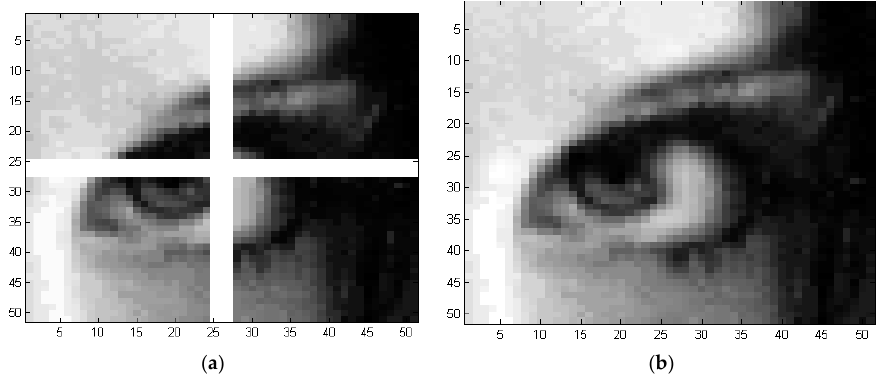
Figure 15. Application of global TPS algorithm in warping images: ( a ) Torn image; ( b ) Warped image.